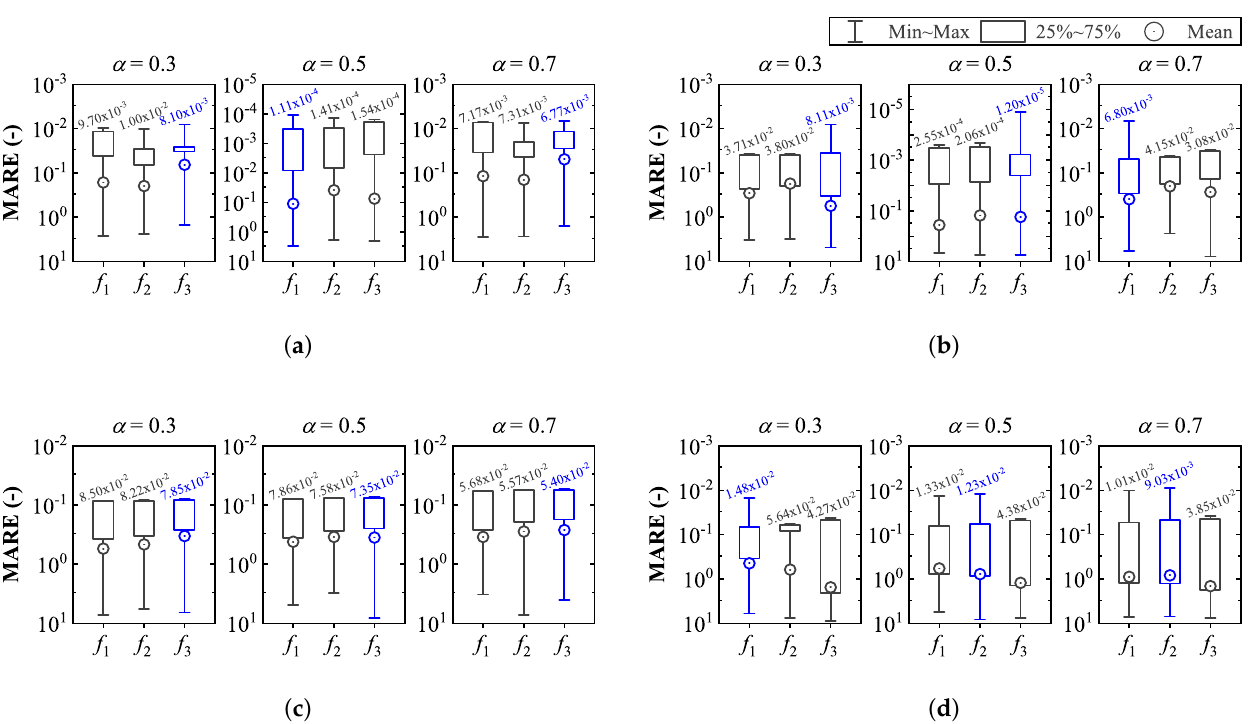
Figure 2. MARE comparison using boxplots for the ( a ) LPPLF, ( b ) HPPLF, ( c ) BPPLF, and ( d ) BSPLF. Note: The most accurate model (lowest MARE min ) for each case is indicated in